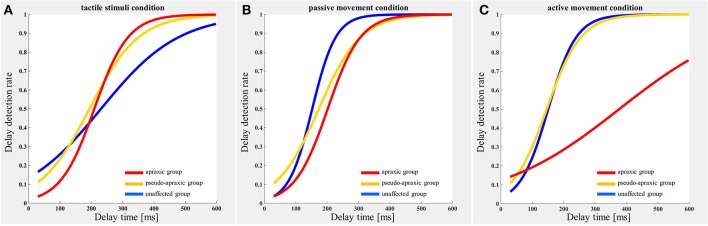
Delay detection probability curve for each condition in each group. Blue, unaffected group (n = 9); yellow, pseudo-group (n = 6); and red, apraxic group (n = 7). (A) Tactile stimuli condition. The delay-detection probability curve shows a similar shape in each group. (B) Passive movement condition. The logistic curve forms were similar to those in (A). (C) Active movement condition. The judgment curve for active movements of the apraxic group showed a different shape from the other groups.